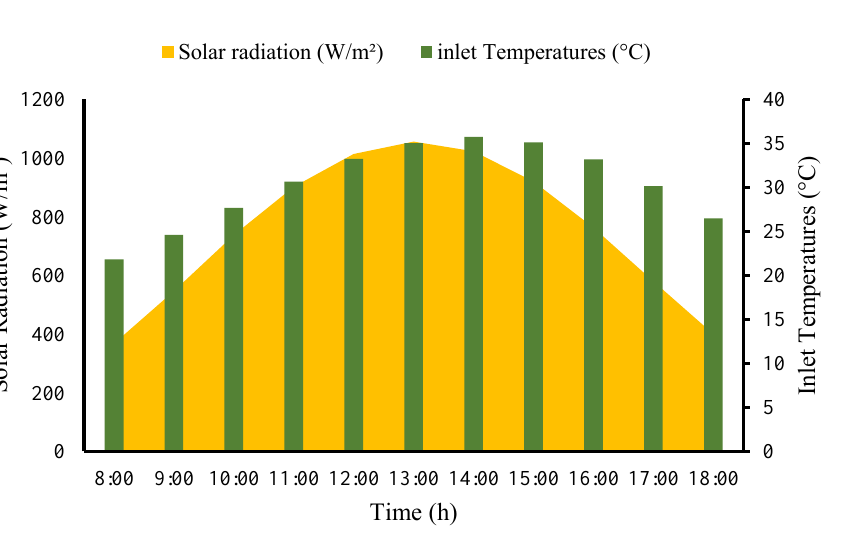
Figure 5. An example of the ray paths and heat flux on the solar air heater